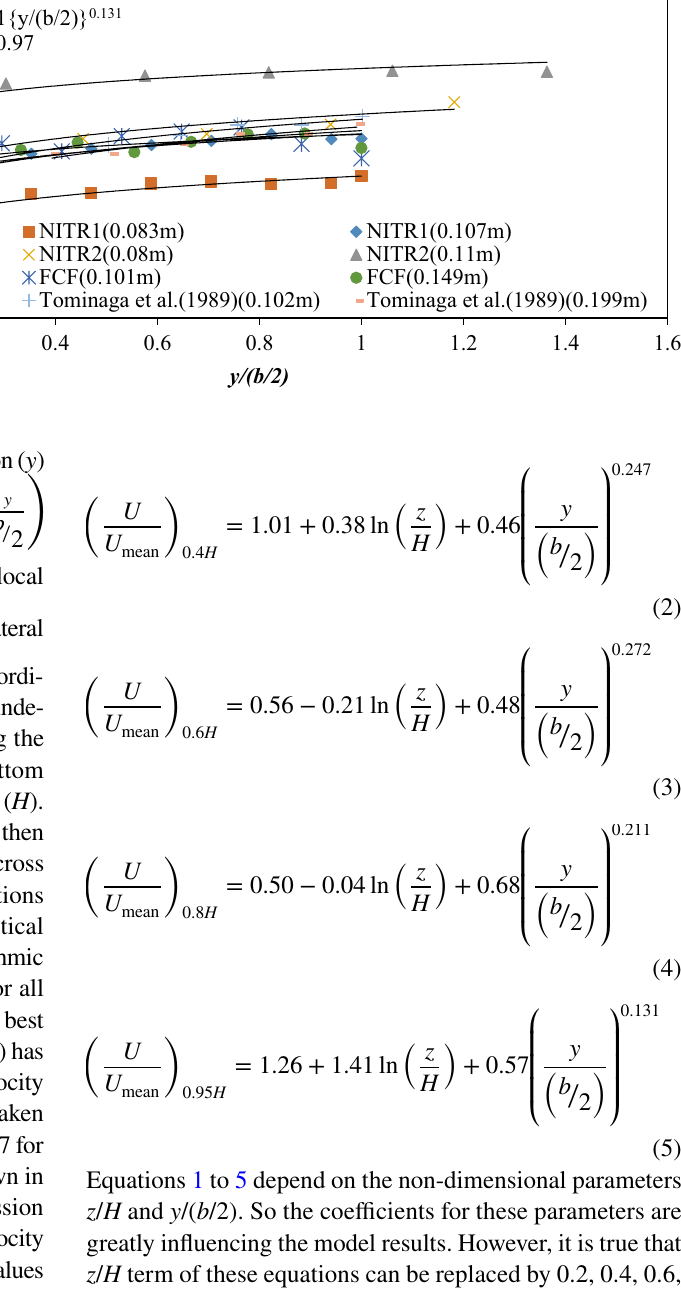
Fig. 8 Lateral variation of dimensionless velocities at a position of 0.95 H